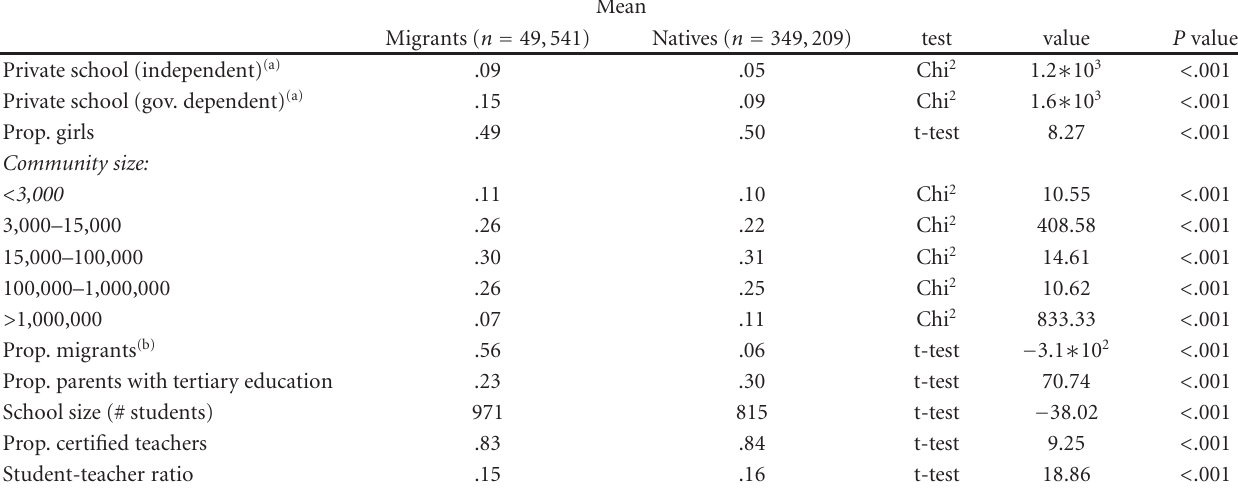
Table 5: School di ff erences by migration